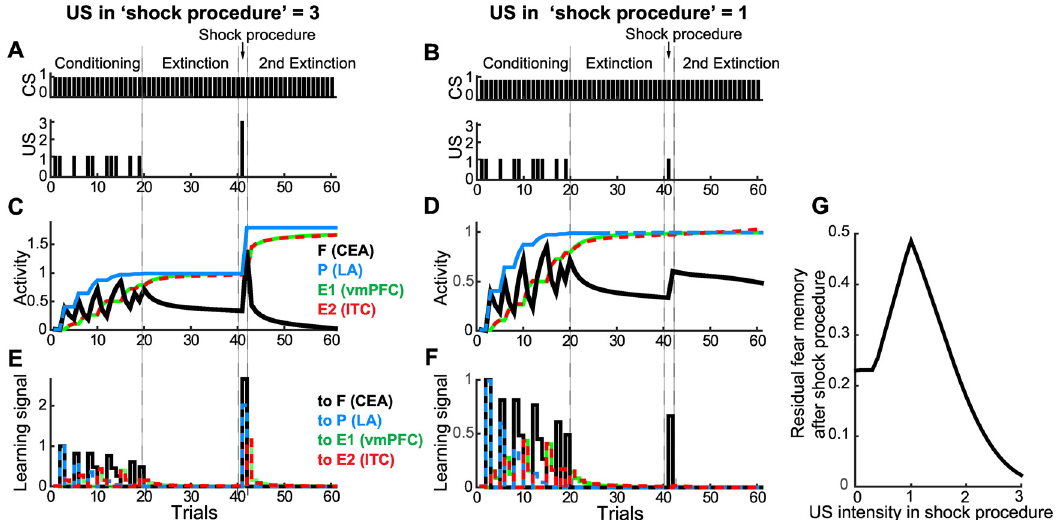
Fig 4. Shock procedure in the extended model. (A, B) CS and US schedules; after extinction training of the partially reinforced fear memory, an additional CS-US pairing was applied, with the US being three times stronger (A) or the same intensity (B) . (C, D) The blue, green, red and black lines indicate the activities of the LA (persistent neurons), vmPFC (extinction neurons), ITC (another group of extinction neurons) and CEA (fear neurons), respectively. (E, F) The blue, green, red and black lines indicate the learning signals that changed the weights of CS-related synaptic input to the LA, vmPFC, ITC and CEA, respectively. Note that overlapped lines were changed to dashed lines to make them visible. (G) Final activity levels of the CEA (fear neural unit) after re-extinction training were plotted depending on the US